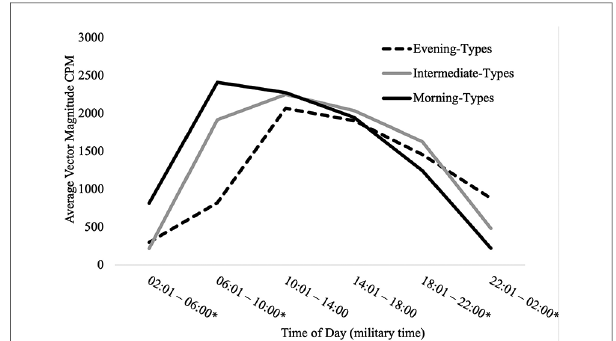
TABLE 4 Chronotype group differences in verbal memory, attention, and executive function factor scores ( N =153).